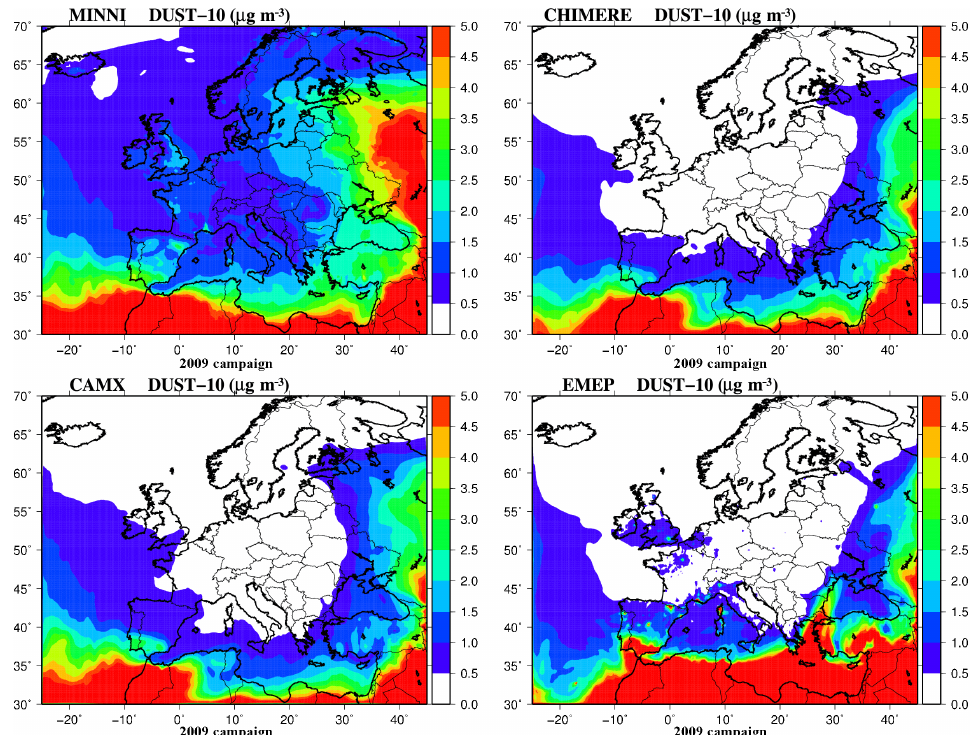
Figure 14. Mean dust concentrations (µgm − 3 ) in the PM 10 fraction for the 2009 campaign computed by the MINNI, CHIMERE, CAMx and EMEP